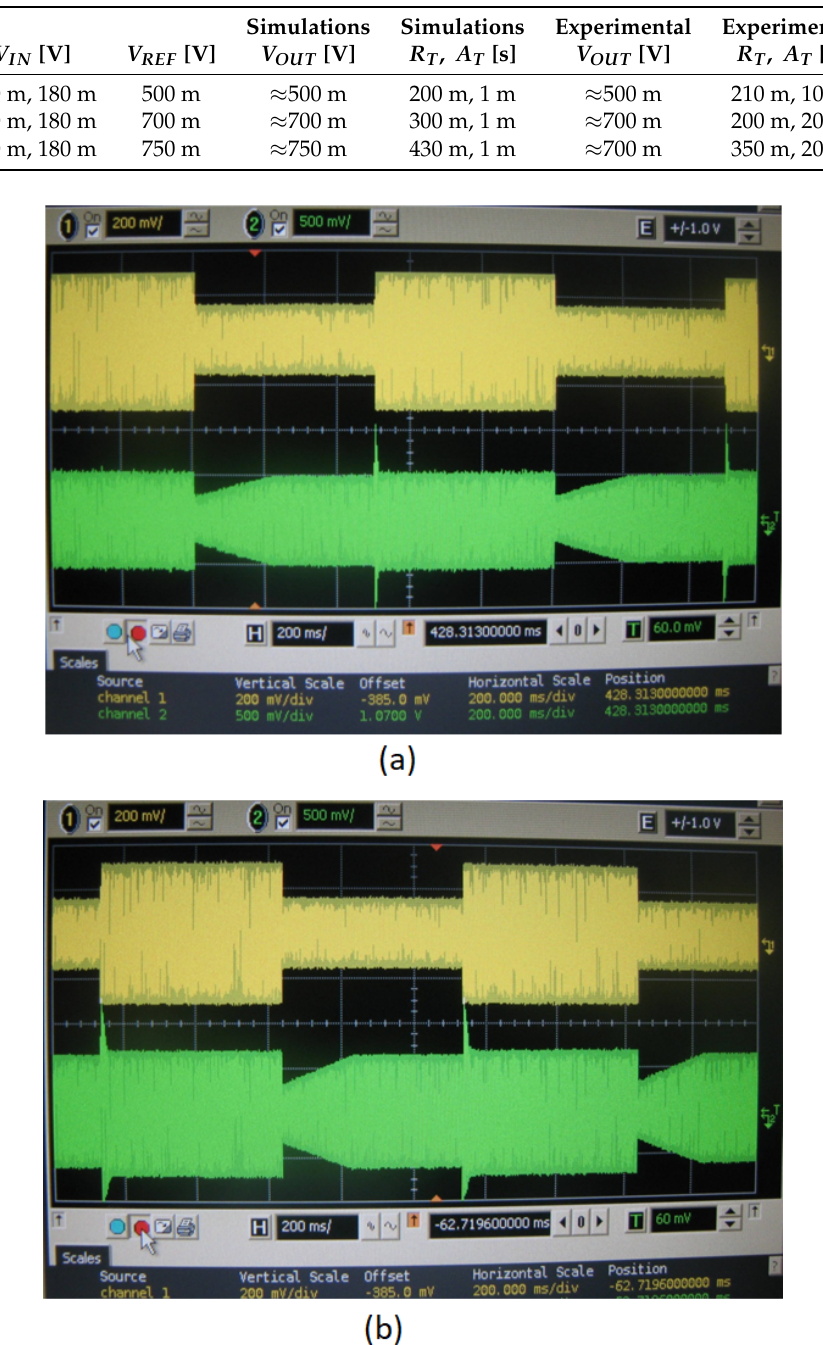
Figure 17. Analog AGC experimental results by setting: ( a ) V REF = 500 mV and ( b ) V REF = 700